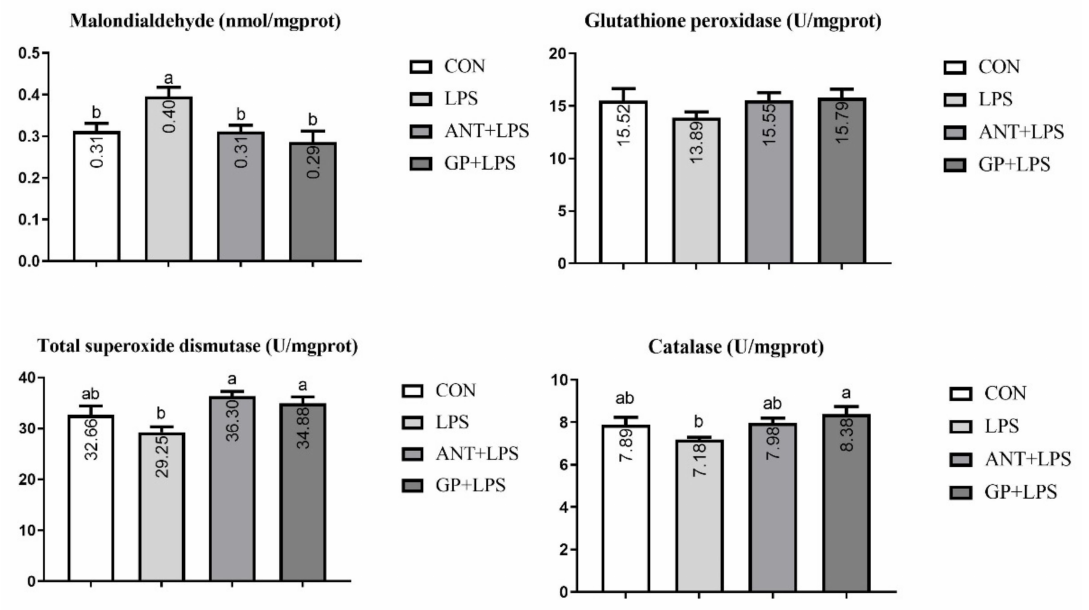
Figure 6. Effects of dietary garlic powder inclusion on antioxidant function of ileum mucosa in broilers challenged with lipopolysaccharide (data were presented as mean and SEM, means that do not share the same superscript are significantly different, p <